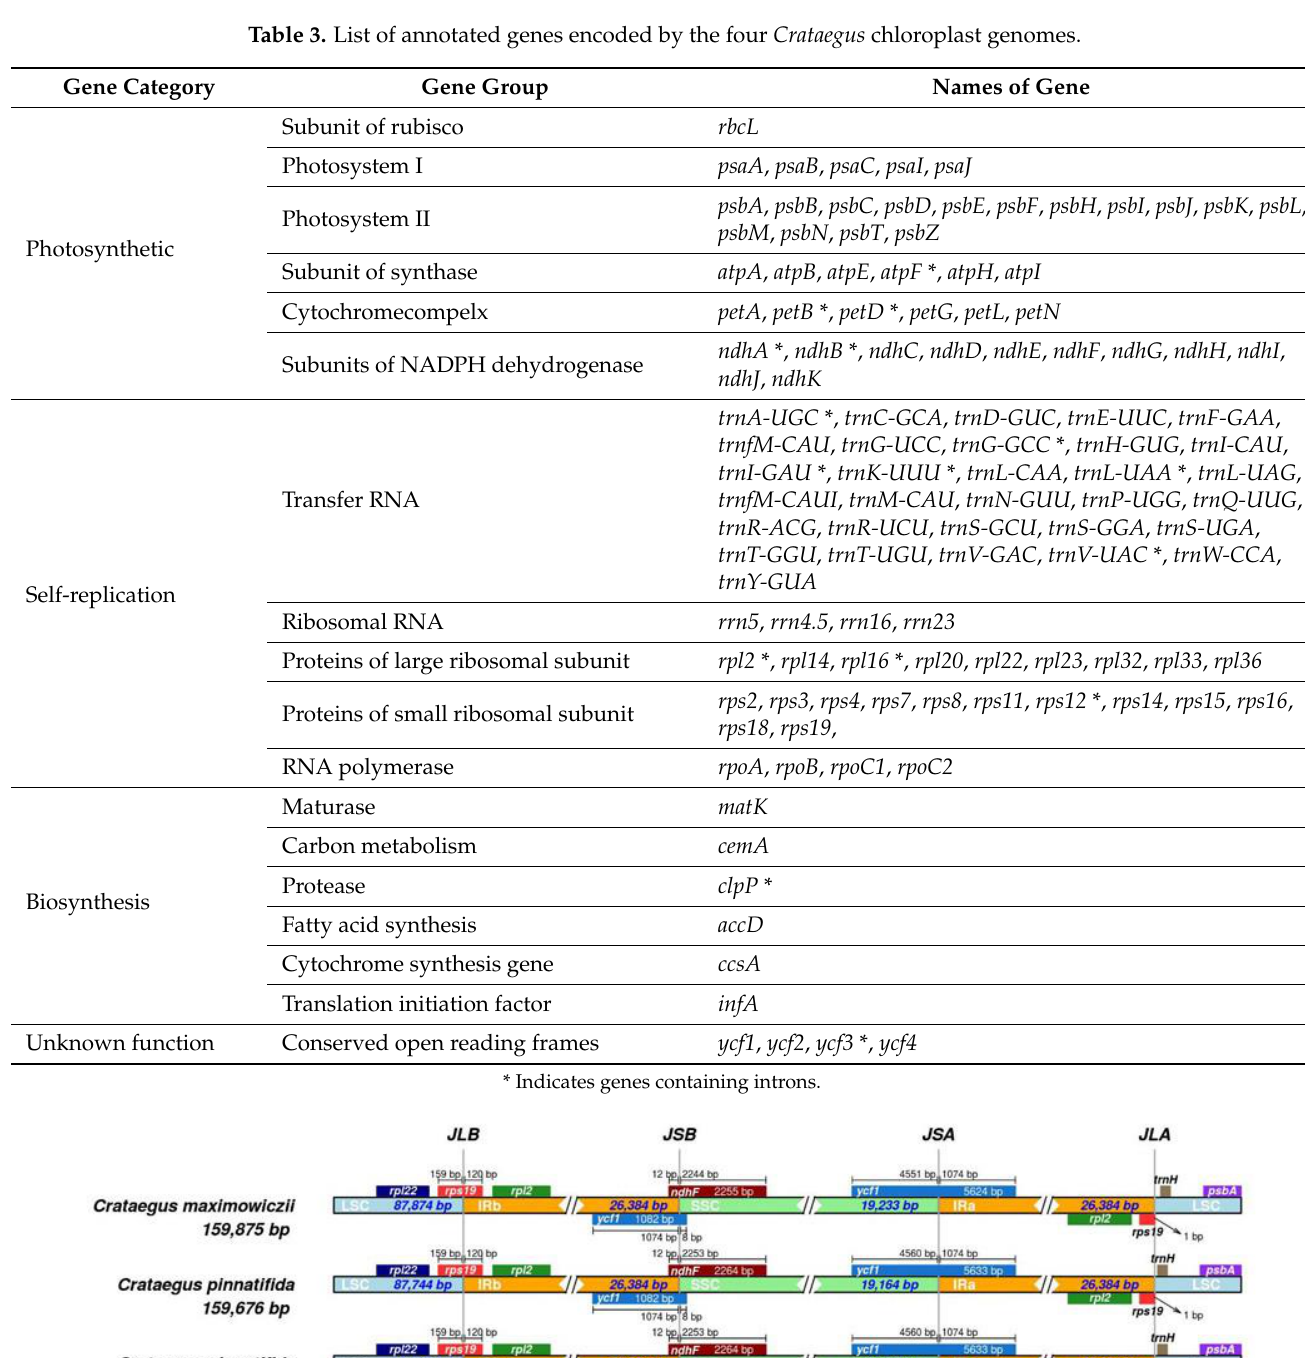
Figure 3. Sequence alignment of the four Crataegus chloroplast genomes in the mVISTA program. C. bretschneideri was employed as a reference. The x -axis indicates coordinates in the chloroplast genome. The vertical axis represents sequence alignment similarity of 50 – 100%. Gray arrow indicates gene orientation. Purple indicates exons, blue indicates introns, and pink indicates conserved non-coding sequences (CNSs).